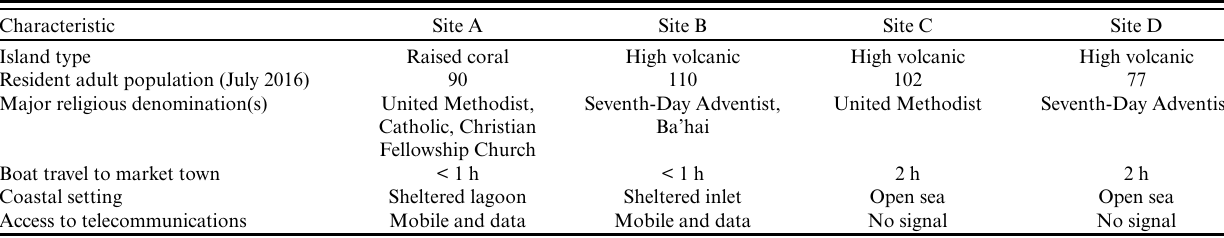
Table 1. Social and ecological characteristics of the four sites, Western Province, Solomon Islands.